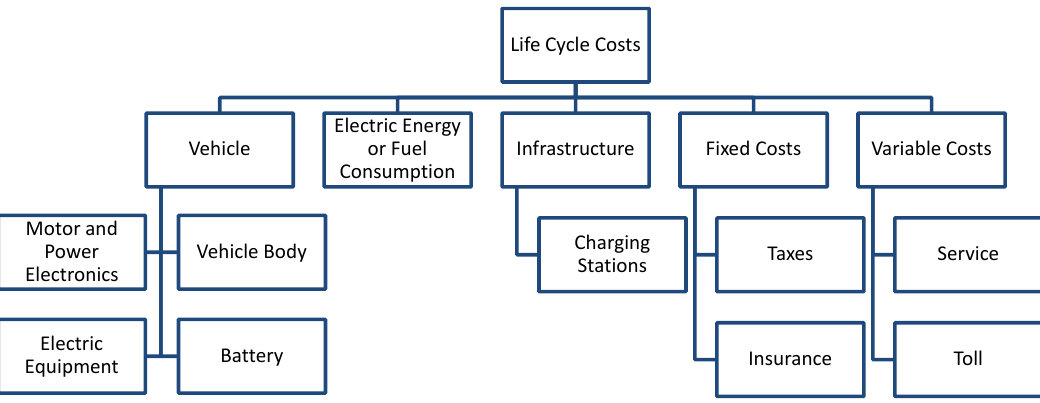
Figure 10. Composition of life cycle costs for the battery electric truck or diesel truck. Table 4. Scenarios and main parameters considered for life cycle costs (LCC) calculation. Scenario Nr.